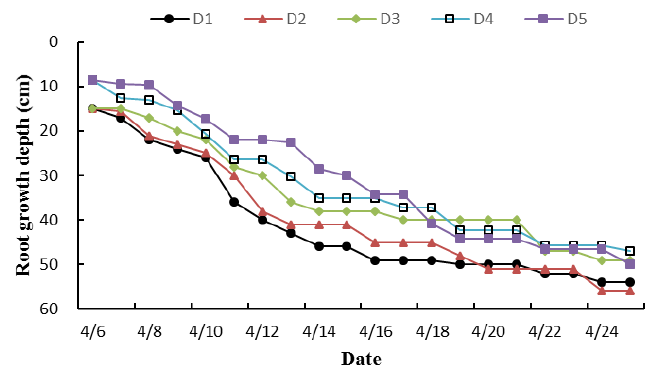
Figure 8. Changes in the root growth depth at different dates for the five treatments.